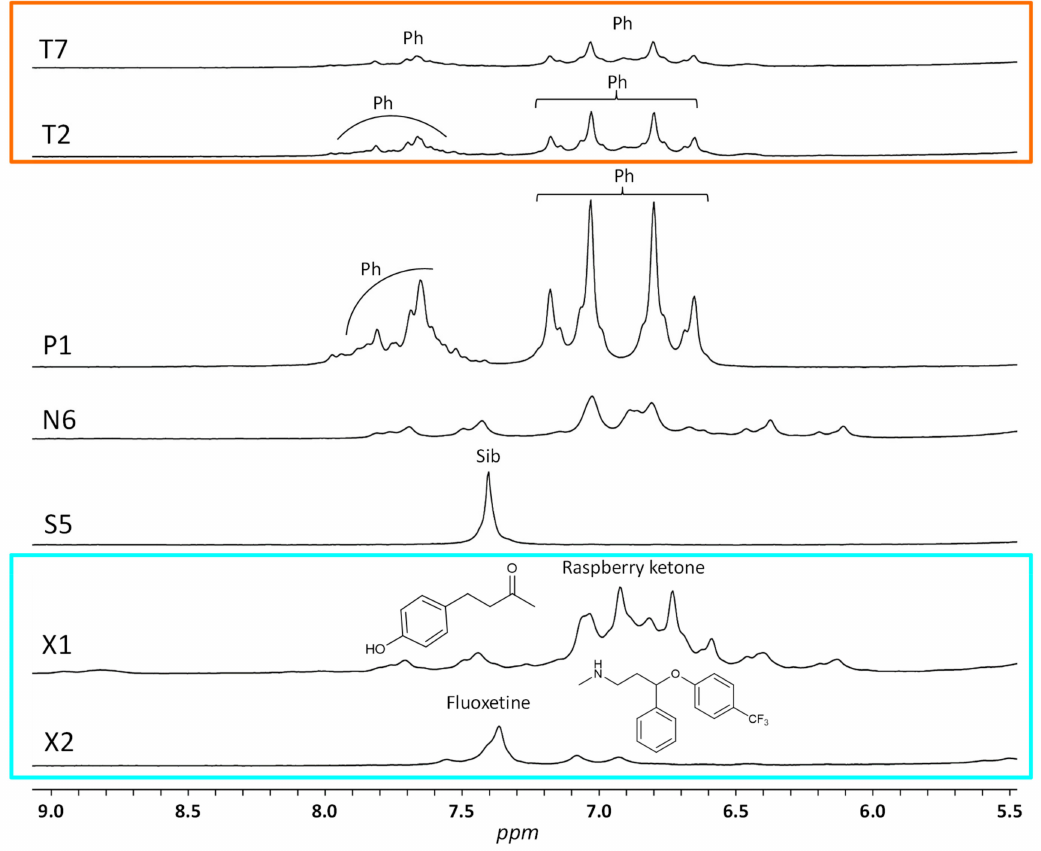
Figure 4. LF 1 H NMR spectra of some weight-loss dietary supplements recorded at 60 MHz. Ph: phenolphthalein; Sib: